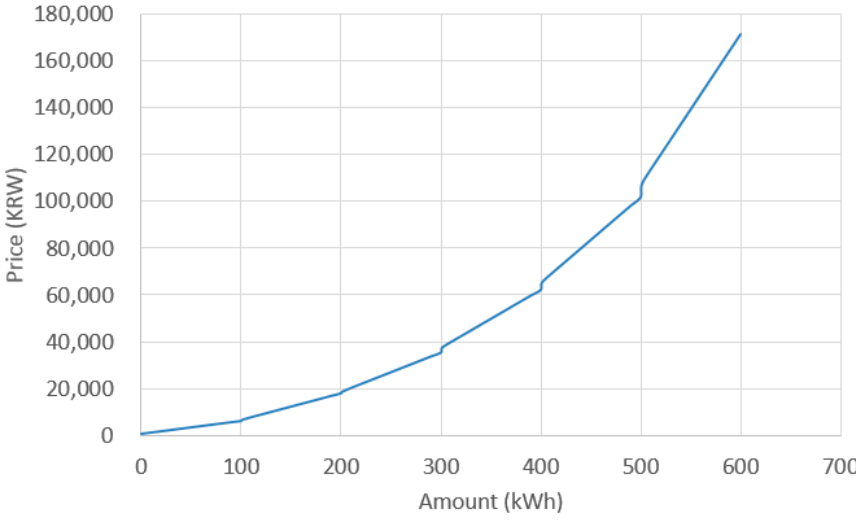
Figure 1. The six-stage progressive electric rate in Korea.